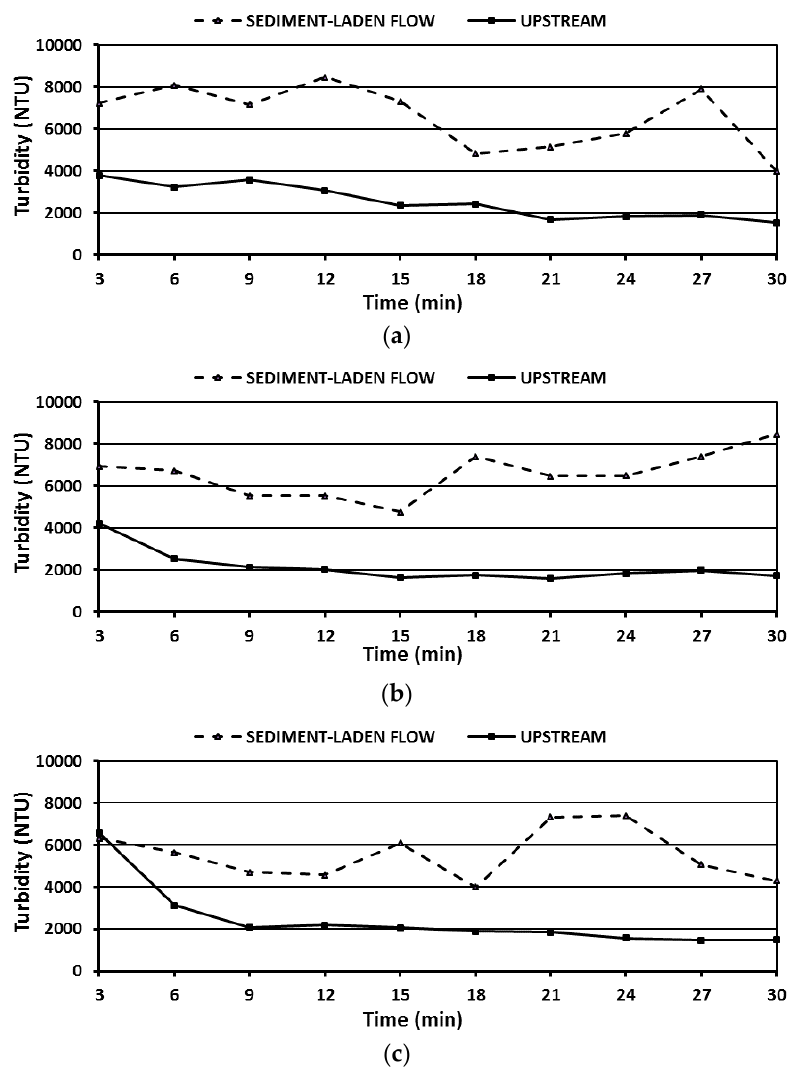
Figure 6. Turbidity reduction due to impoundment of the AL-SWCC Trenched Silt Fence , ( a ) average performance test 1 (P-1), ( b ) average performance test 2 (P-2), ( c ) average performance test 3 (P-3).